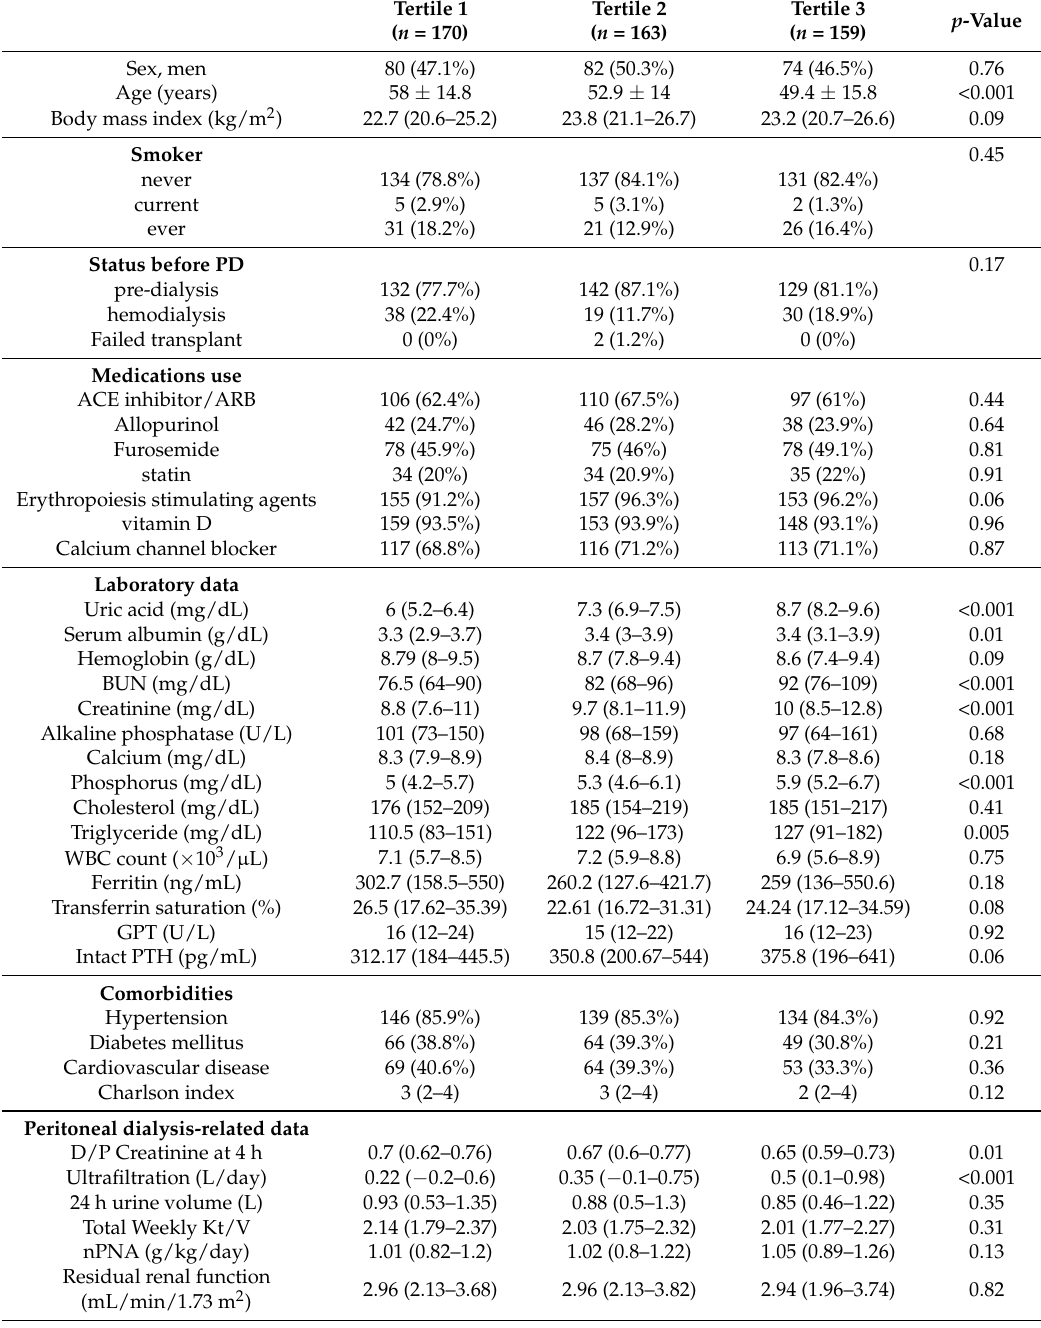
Table 1. Baseline characteristics of the study population by sex-specific uric acid tertiles ( n =